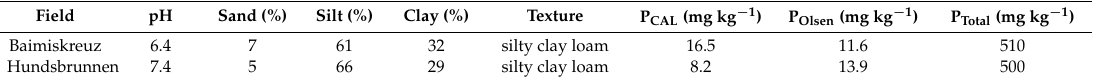
Table 1. Important basic characteristics of experimental